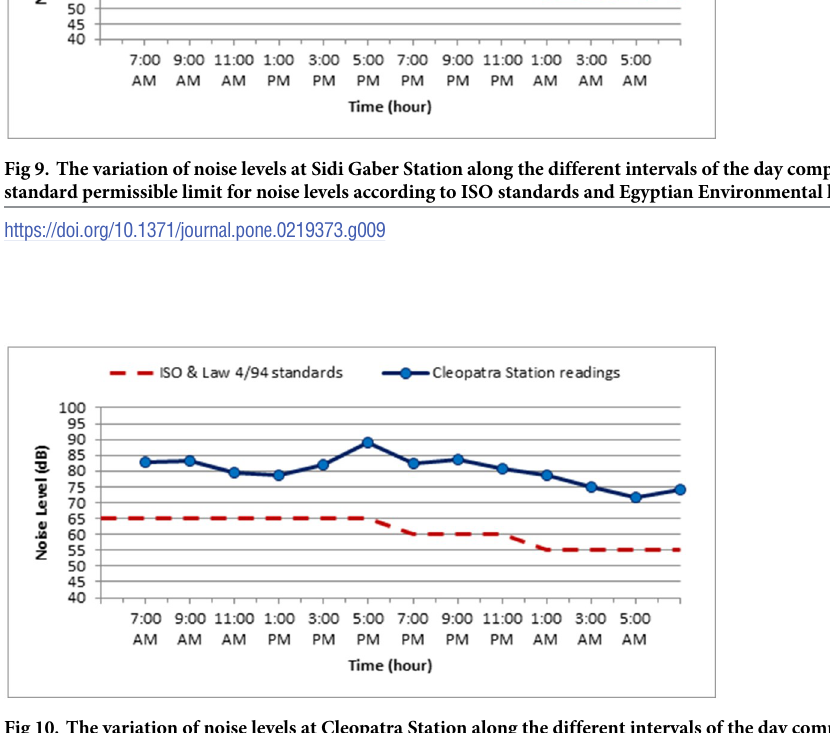
Fig 10. The variation of noise levels at Cleopatra Station along the different intervals of the day compared to the standard permissible limit for noise levels according to ISO standards and Egyptian Environmental law 4/94.